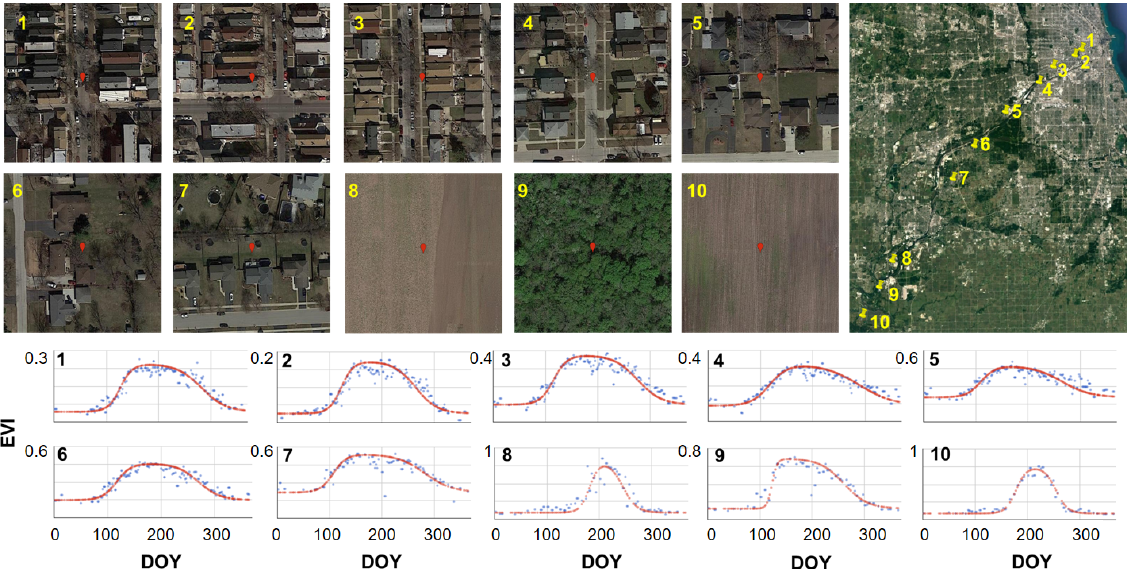
Figure 5. Performance of the Google Earth Engine (GEE)-based double logistic model for sites from the urban center to rural areas in the Chicago metropolitan area. Each snapshot indicates a 1km 2 square, and the red dot in the middle is the location (30m) of the enhanced vegetation index (EVI) time series